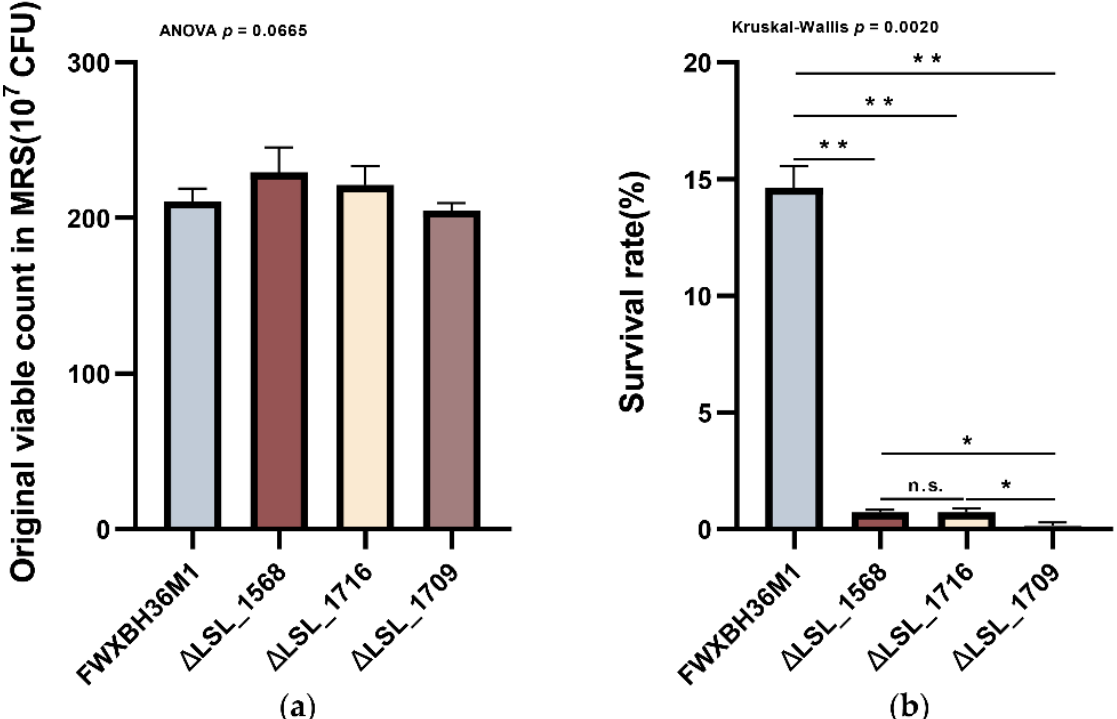
Figure 5. Knockout of the functional genes in L. salivarius strain FWXBH36M1. ( a ) Growth profiles of three in-frame deletion mutants and the wild-type strain in MRS medium. One-way ANOVA was applied for the group comparison; ( b ) Survival rates of three in-frame deletion mutants and the wild-type strain in 0.3% bile salt solution. Kruskal–Wallis test and Tamhane T2 post hoc analysis were applied for the group comparison. Symbols indicate significance (** p < 0.01, * p < 0.05).